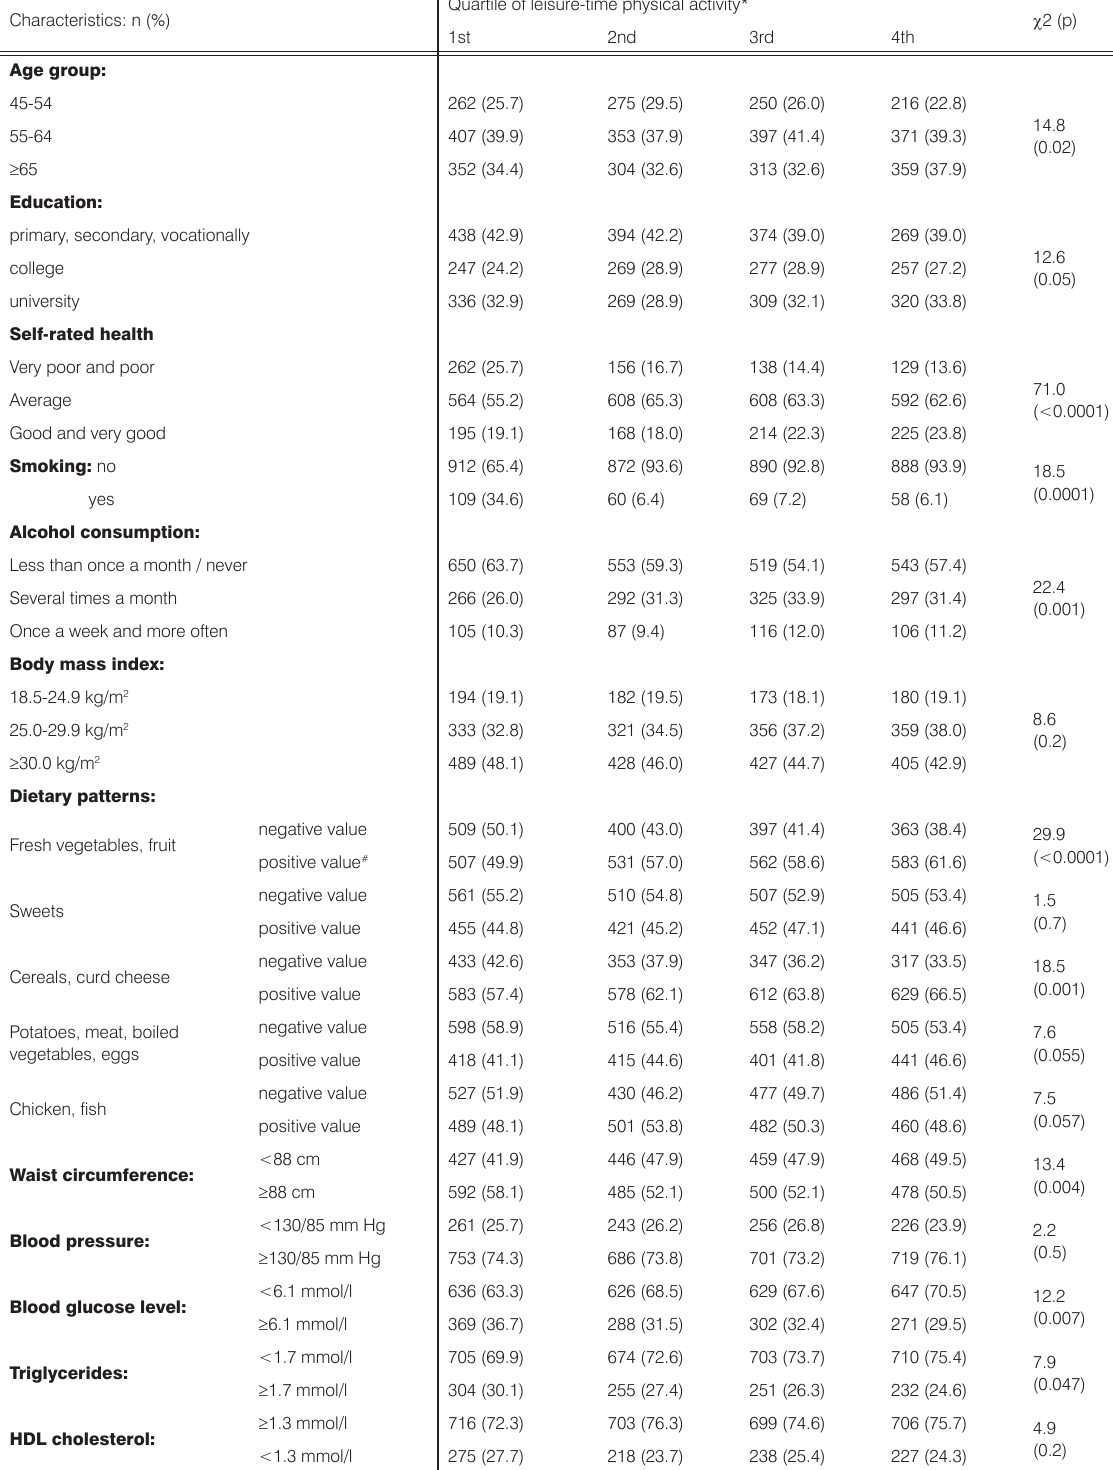
Table 2. Characteristics according to leisure-time physical activity level in middle- and older-aged women Characteristics: n